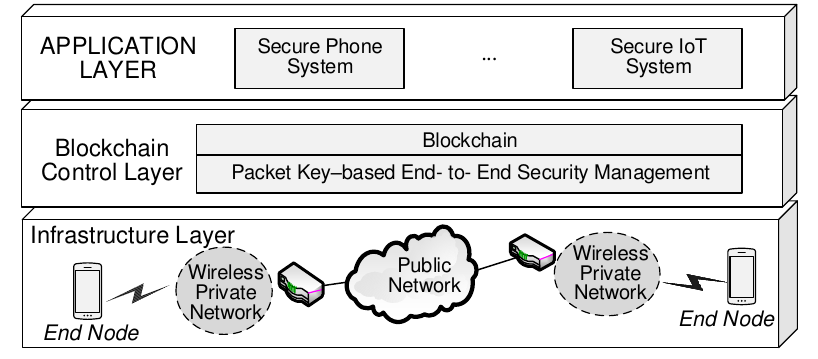
Figure 2. End-to-end packet key-based security management on the blockchain control